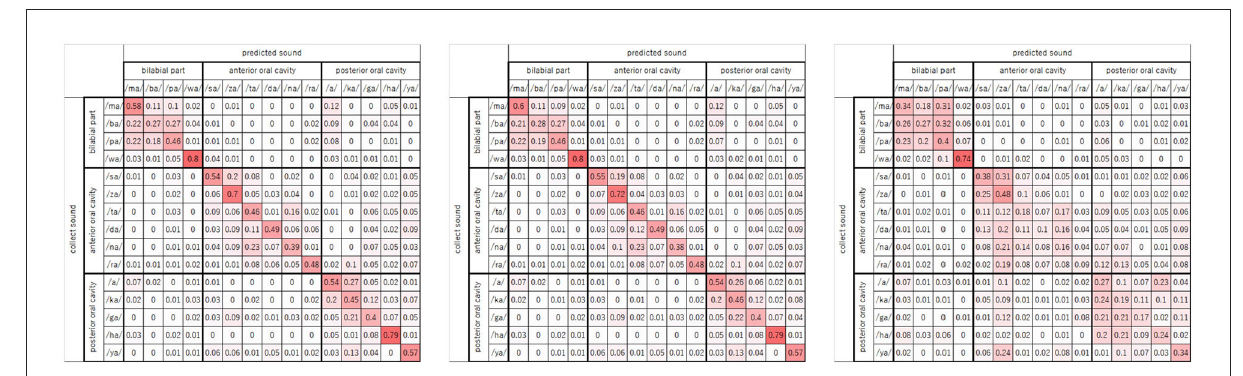
FIGURE10 Consugion matrices ( left : α = 0.0, center : α = 0.1, right : α = 1.0).